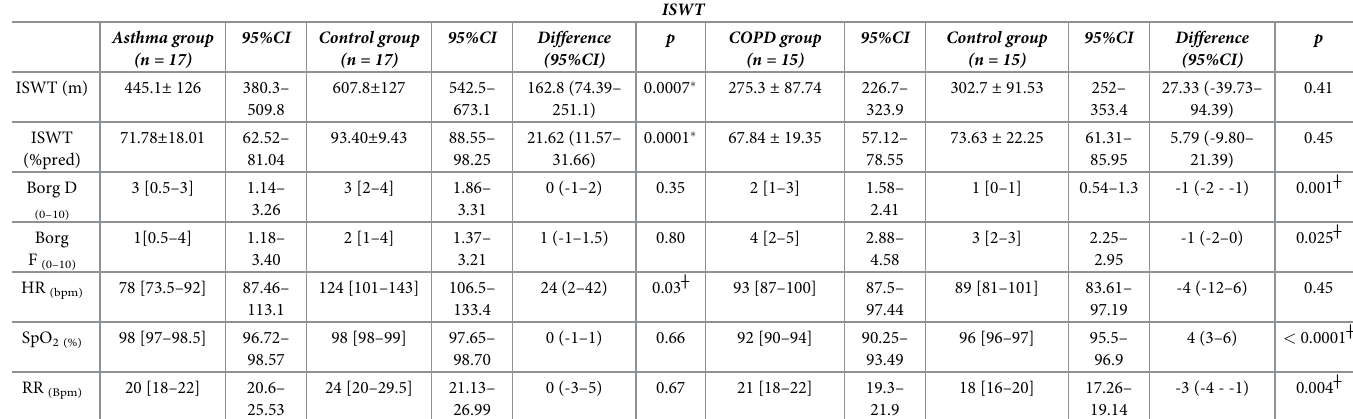
Table 3. Results of